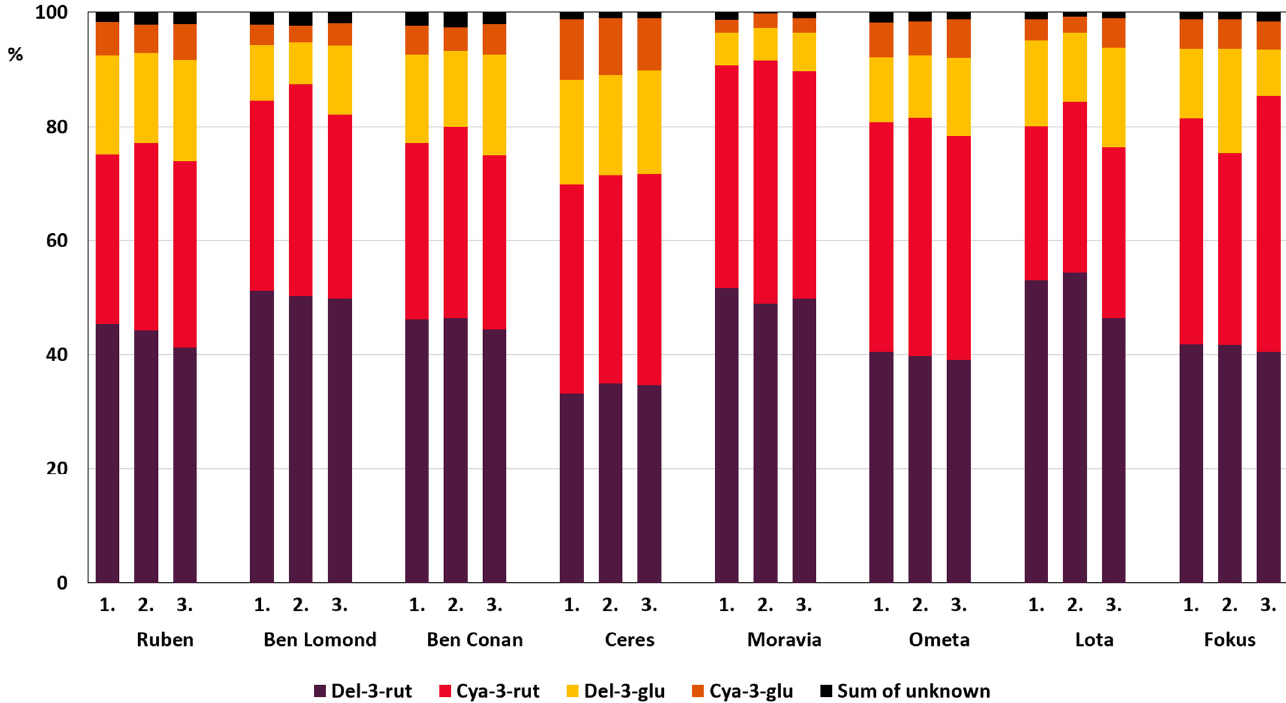
Figure 3. Representation (%) of blackcurrant anthocyanins in eight blackcurrant cultivars measured throughout the three-year experiment.